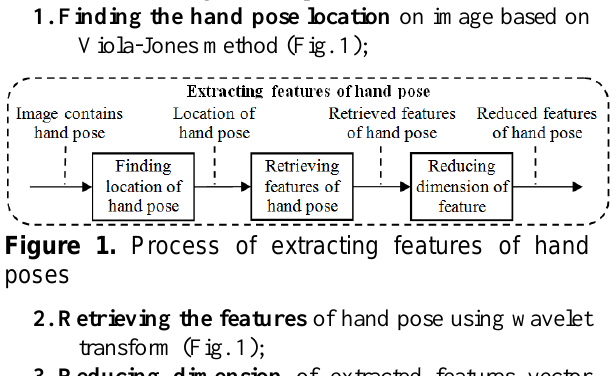
Figure 1. Process of extracting features of hand poses